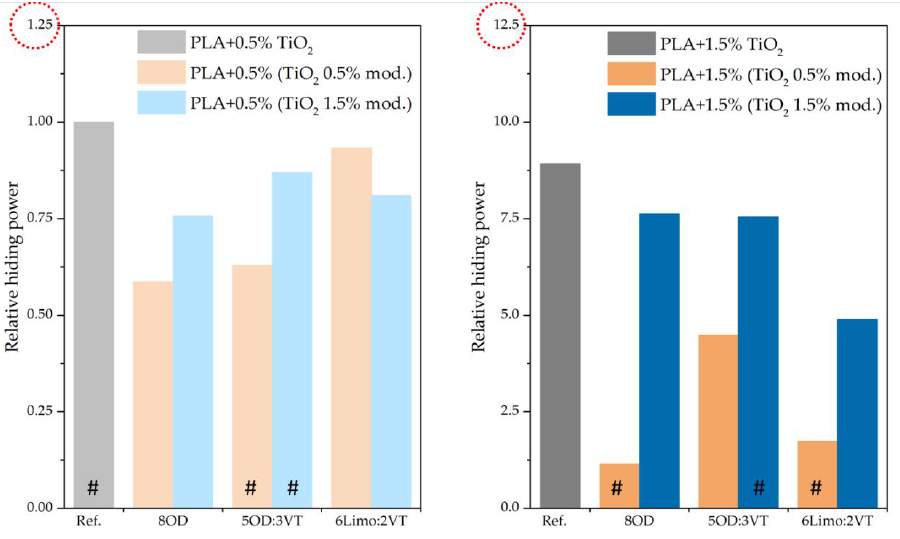
Figure 8. Results of the relative hiding power.